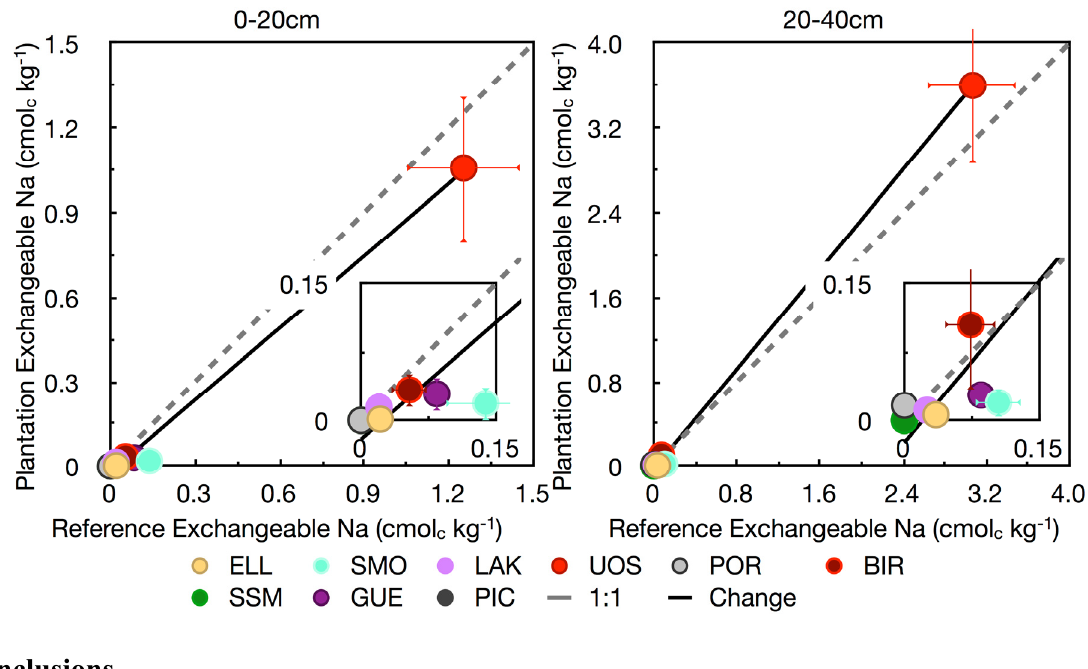
Figure 6. Initial concentration of exchangeable Na, as estimated from reference sites, versus exchangeable Na concentration in plantations after the first rotation of nine S. purpurea “Hotel” plantations (ELL, SMO, LAK, UOS, POR, BIR, SSM, GUE, and PIC). Inset shows expanded view of low values. Error bars represent standard error when greater than symbol